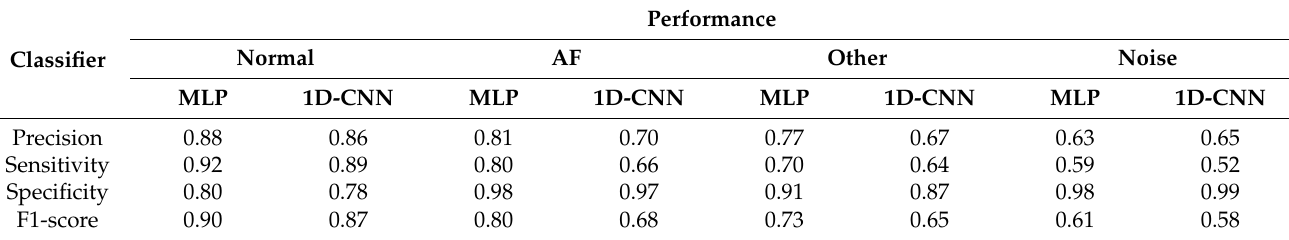
Table 2. Performance of the proposed classifiers for each